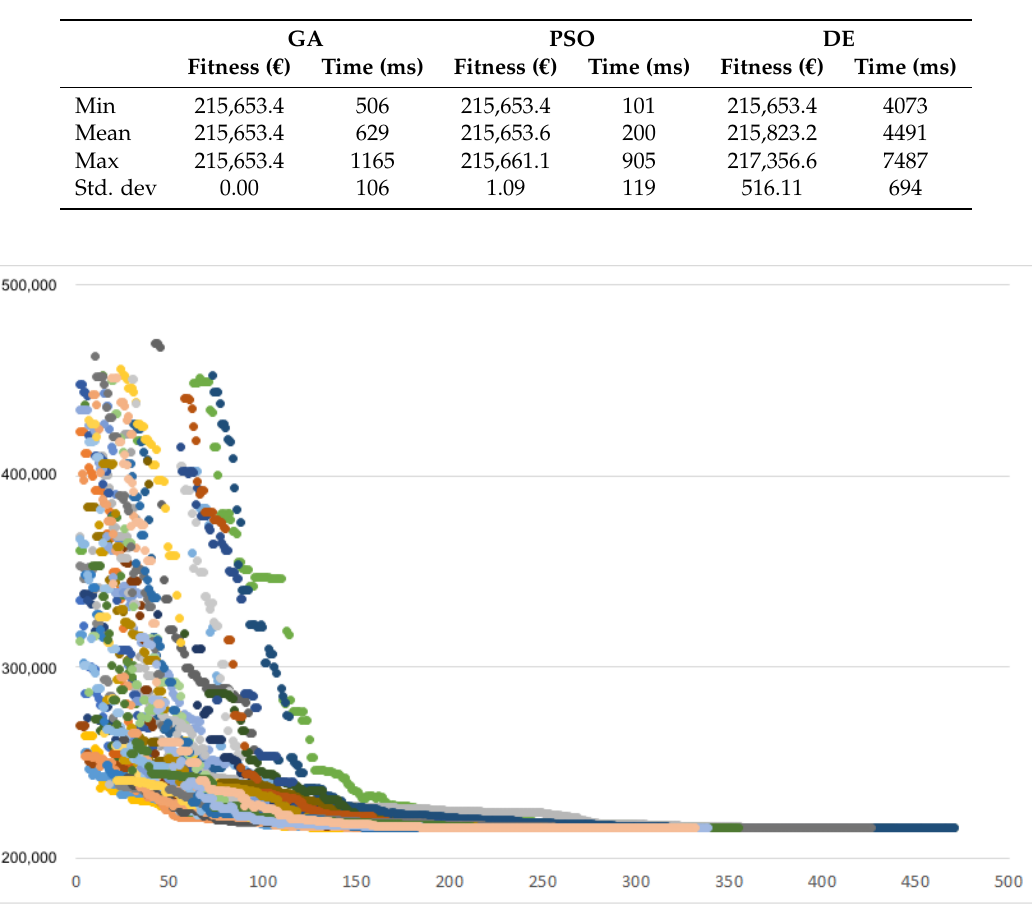
Figure 9. Convergence history of feasible solutions obtained by the 50 independent runs of the genetic algorithm. Numer of executions in horizontal axis and fitness in vertical axis. Every run has a different